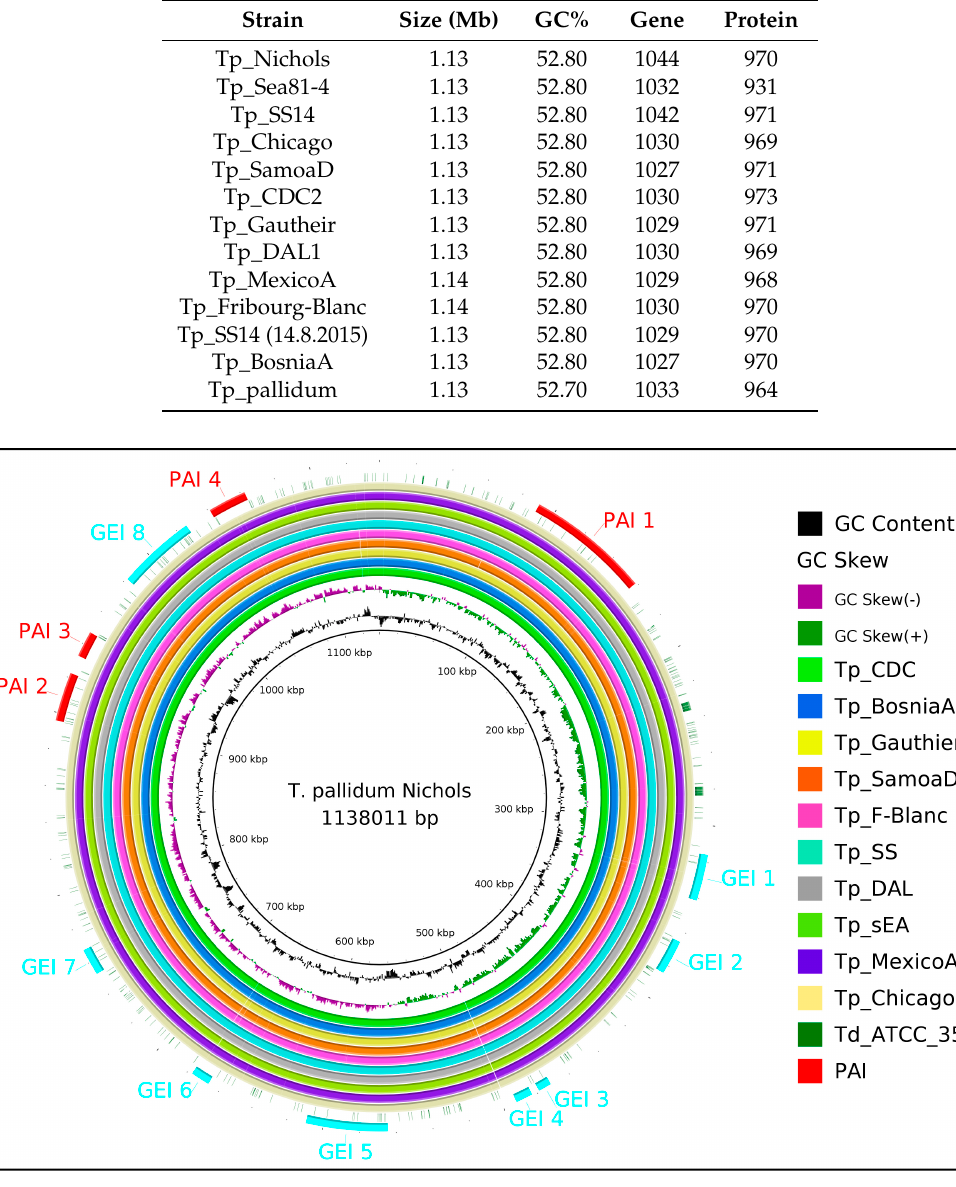
Figure 2. Genomic islands (GIs) of T. pallidum Nichols strains as predicted by the genomic island prediction software (GIPSy) using Treponema denticola as a closely related non-pathogenic organism. The outermost circle highlighted in red shows the four pathogenicity islands from 10 GIs. Guanine-Cytosine (GC) content is shown in black.